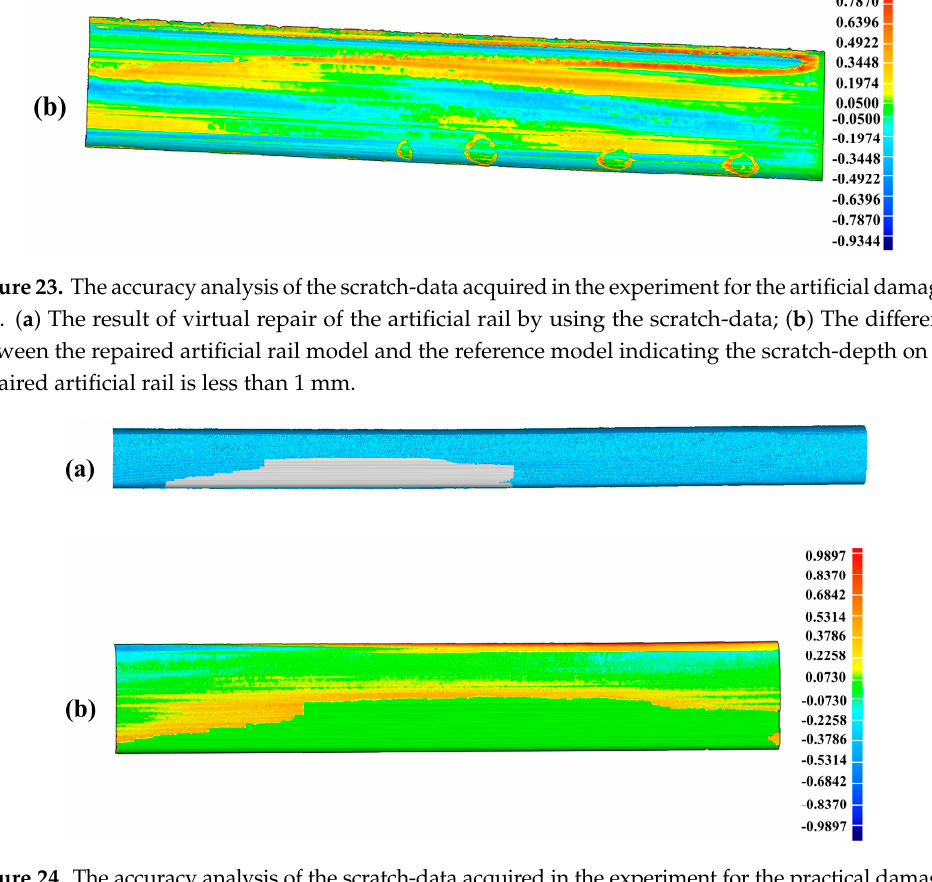
Figure 24. The accuracy analysis of the scratch-data acquired in the experiment for the practical damaged rail. ( a ) The result of virtual repair of the practical rail by using the scratch-data; ( b ) The difference between the repaired practical rail model and the reference model indicating the scratch- depth on the repaired practical rail is less than 1 mm. Table 11. The analysis result of the repaired practical